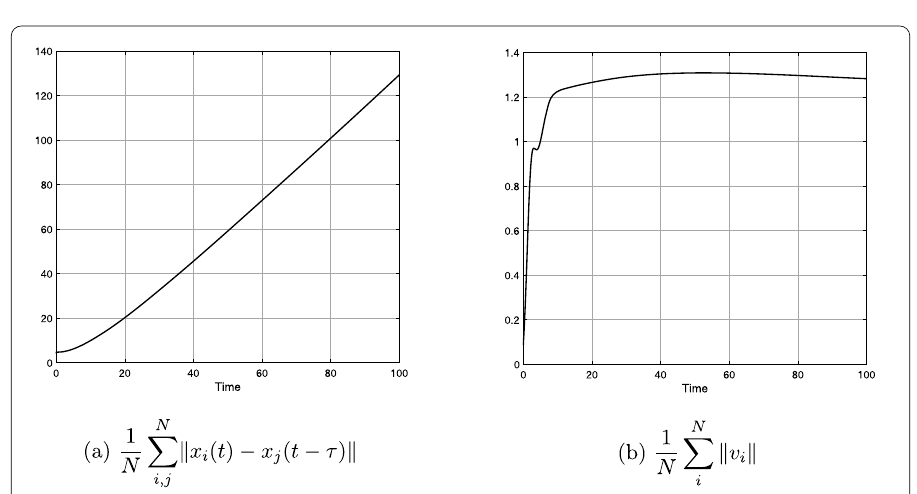
Figure 9 The average distance between agents and the average velocity of agents of Case II for t ∈ [0,100]